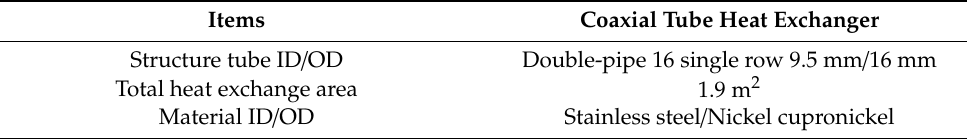
Table 1. Dimensions of the heat